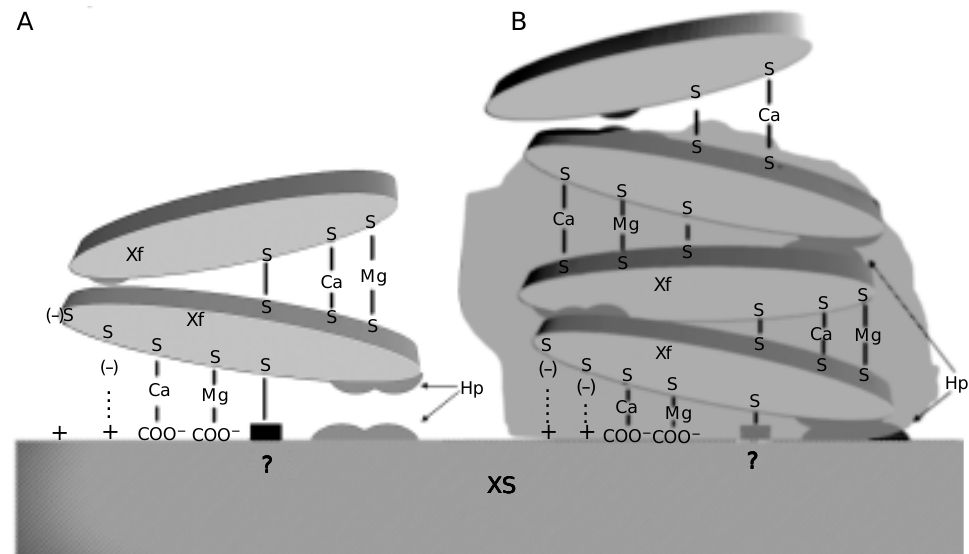
Figure 2. Model proposed to explain adhesion and aggrega- tion of Xylella fastidiosa . In scheme A an X. fastidiosa cell (Xf) is placed in contact with the xylem surface (XS) and with an- other bacterial cell. All potential points of adhesion are repre- sented. In the interaction be- tween X. fastidiosa cells and the XS hydrophobic interactions oc- cur between hydrophobic (Hp) portions on both sides and addi- tional interactions occur be- tween the surface sulfur (sulf- hydryl groups) and charges lo- calized on the xylem side (S-? S-+) directly or bridged by cal- cium and magnesium (S-Ca- COO - , S-Mg-COO - ). In contrast, cell-to-cell adhesion is believed to be mediated by hydrophobic interactions as just described, by the formation of disulfide bonds (S-S) and by sulfur groups bridged by divalent ions (S-Ca- S, S-Mg-S). The situation de- scribed in B involves multilay- ered deposition of cells sup- ported by the architecture pro- vided by exopolysaccharides, with the fastidium gum being represented by the